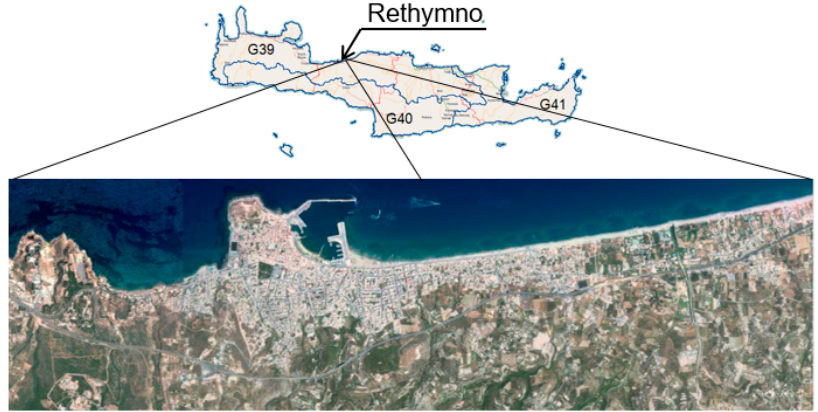
Figure 16. Rethymno city under study and its location on the island of Crete, Greece.